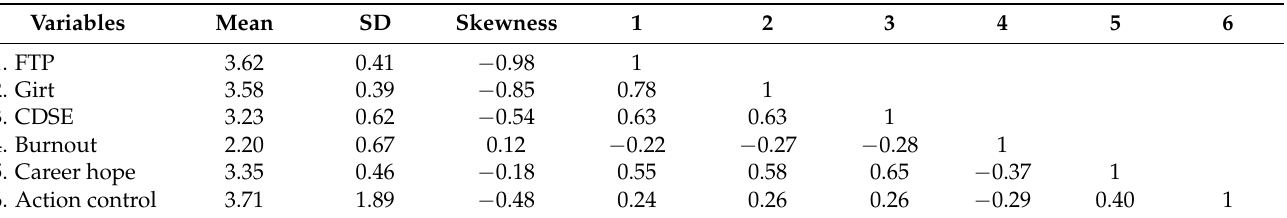
Table 2. Descriptive statistics and correlation